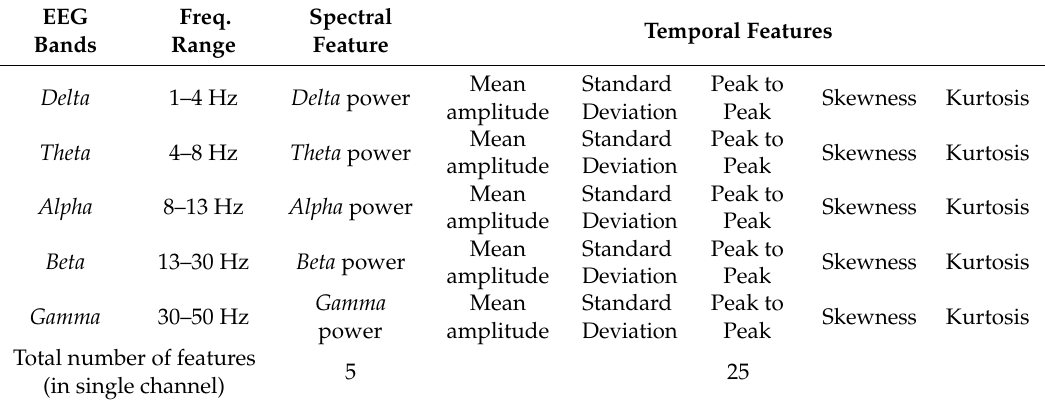
Table 1. Description of extracted features.